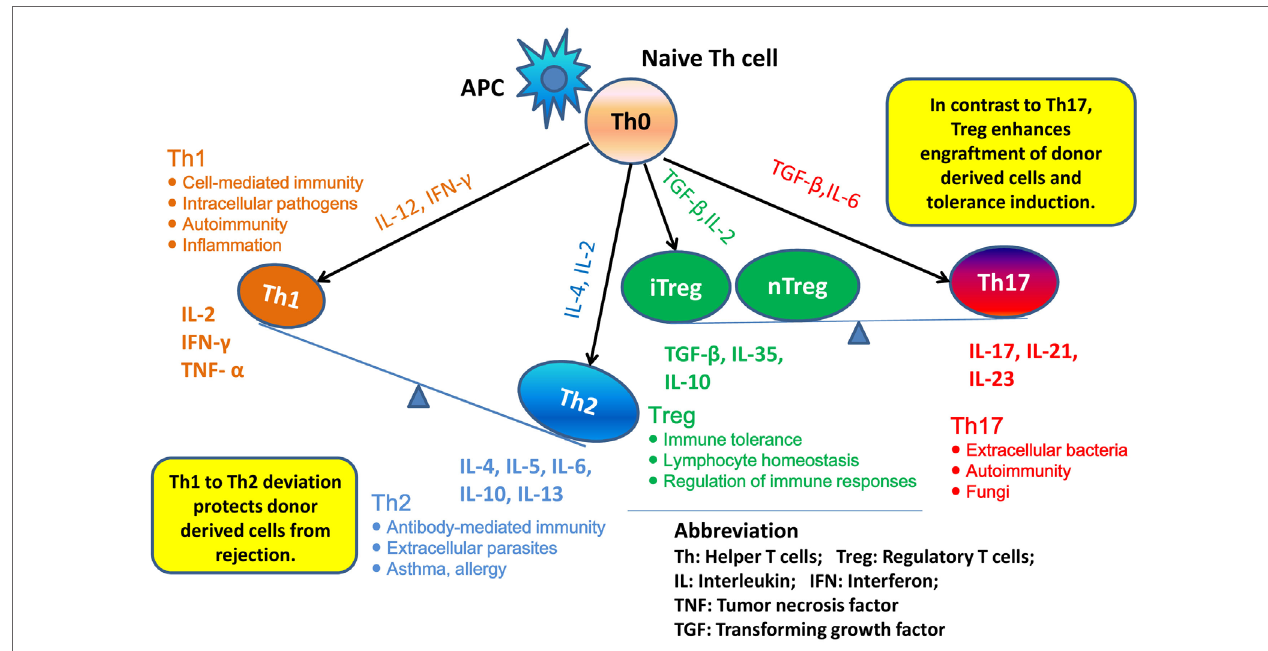
FiGURe 1 | Th1 to Th2 deviation and Th17–Treg axis . Following activation by antigen-presenting cells (APCs), naive Th cells can be polarized into different effector T cell subsets: T helper 1 (Th1), Th2, Th17, and induced regulatory T (iTreg) cells, depending on the local cytokine environment. Besides iTreg, there is another Treg subset, “natural” Treg (nTreg), which develops as a distinct lineage in the thymus. In neonatal mice, newborn T cells generate Th2-biased immune response, thus may protect donor cells from rejection. nTreg and iTreg are critical in the mechanism of neonatal tolerance induction. They promote the donor cells engraftment and tolerance induction. By contrast, promotion of Th17 immunity can prevent establishment of lymphoid chimerism and neonatal tolerance